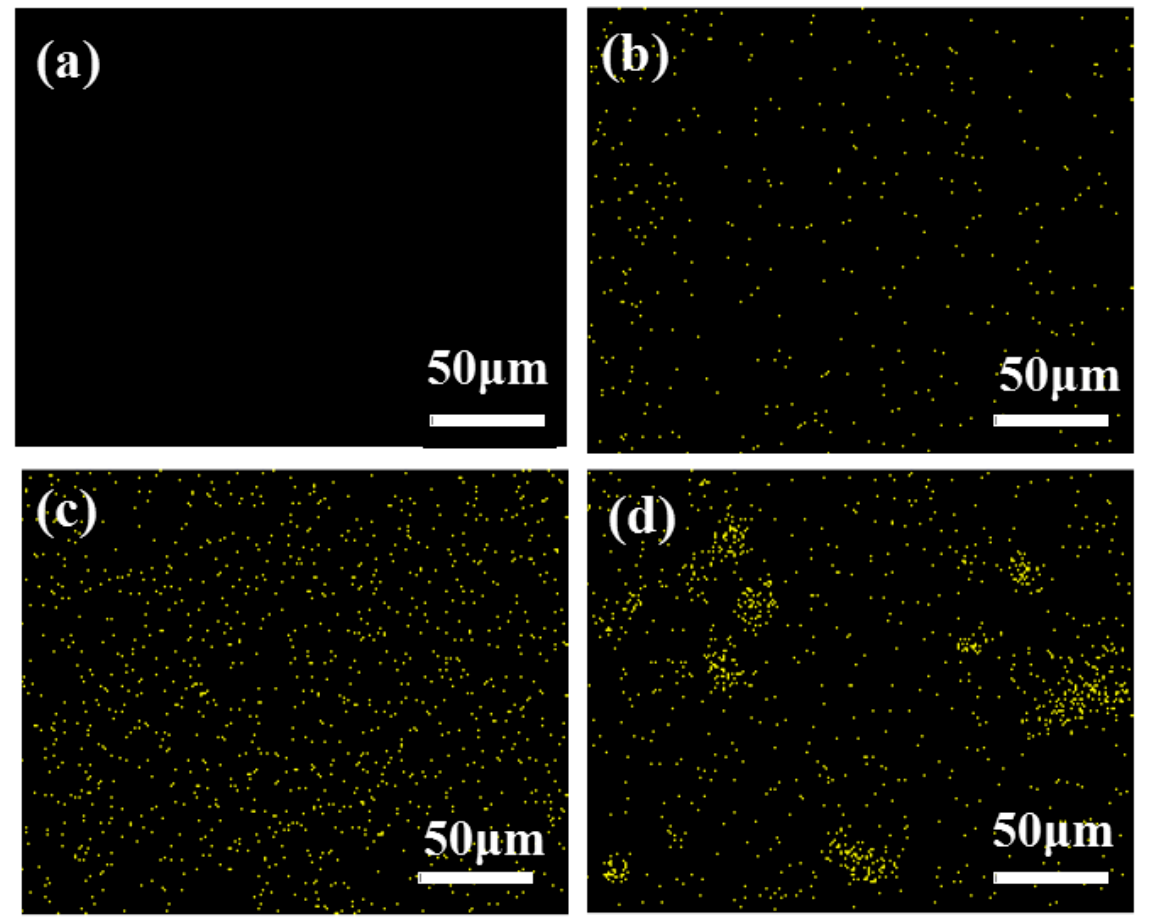
Figure 6. EDS images of Si of basalt fiber reinforced epoxy resin with different content of nano ‐ silica: ( a ) 0 wt%; ( b ) 0.2 wt%; ( c ) 0.4 wt%; ( d ) 0.6 wt%.